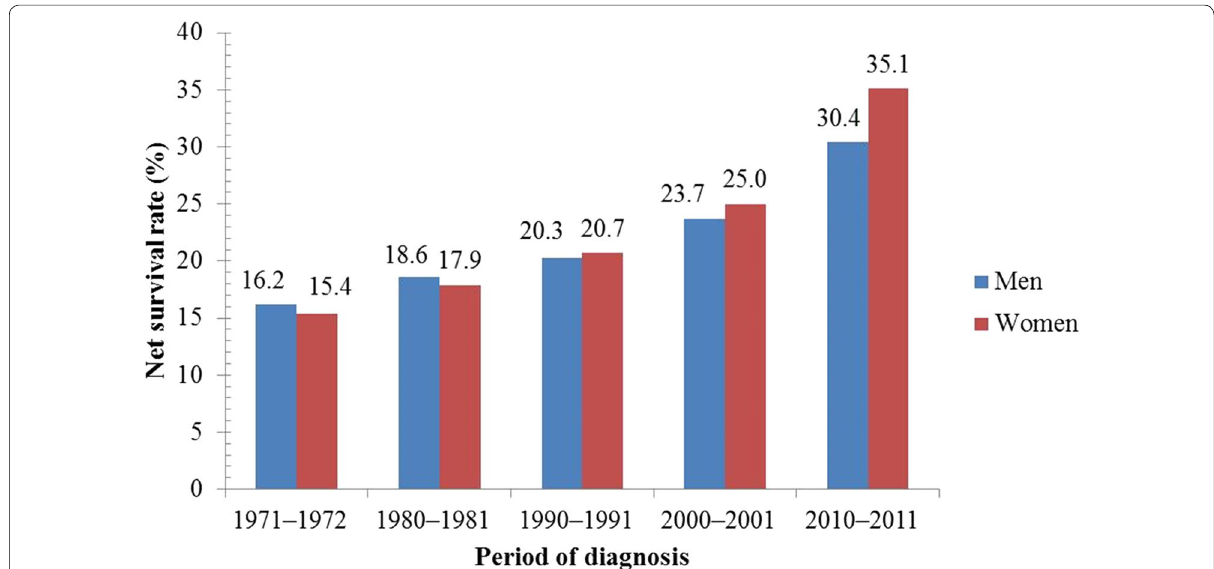
Fig. 1 One-year net survival trends of lung cancer patients in the United Kingdom (UK). During the period 1971–2011, the 1-year age-standardized (age 15–99 years) net survival rates of men with lung cancer increased from 16.2% to 30.4%; for women, the survival rate increased from 15.4% to 35.1% during the same period